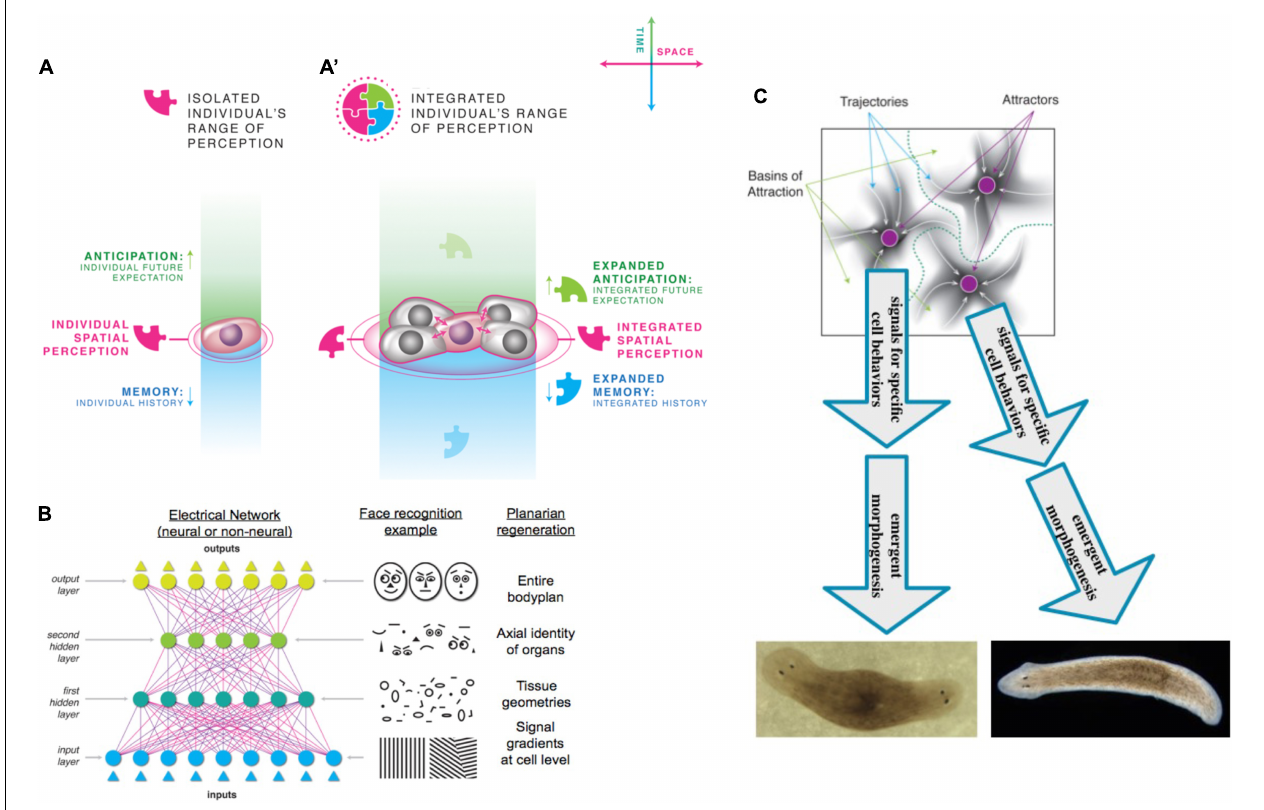
FIGURE 8 | Scaling of computation in cells. Individual cells (A) have a degree of computational capacity consisting of the ability to sense local microenvironment, and some memory and ability to anticipate into the future. When assembling into networks (A (cid:48) ) , tissues acquire the ability to sense and act at greater spatial distance, as well as gain larger capacity for memory and prediction via greater computational capacity. As neural networks use hidden layers to abstract patterns in data and recognize meso-scale features (B) , tissue networks gain the capacity to represent information larger than the molecular and cell level: each cell’s activity (differentiation, migration, etc.) can be the result of other layers of cells processing information about current and past states, enabling decision-making with respect to tissue, organ, or whole organism-scale anatomy. (C) Much as some neural networks store individual memories as attractors in their state space, bioelectric circuits’ attractors function as pattern memories, triggering cells to execute behaviors that implement anatomical outcomes like number and location of heads in planaria. Images courtesy of Jeremy Guay of Peregrine